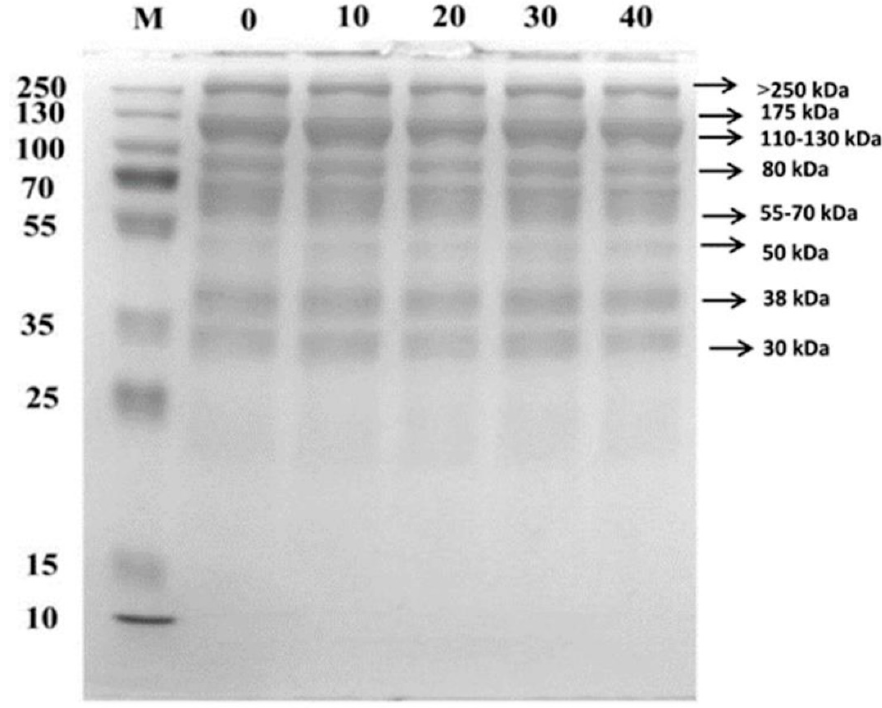
Figure 5. Electropherograms of SDS-PAGE of egg yolk under different ozone treatment times.